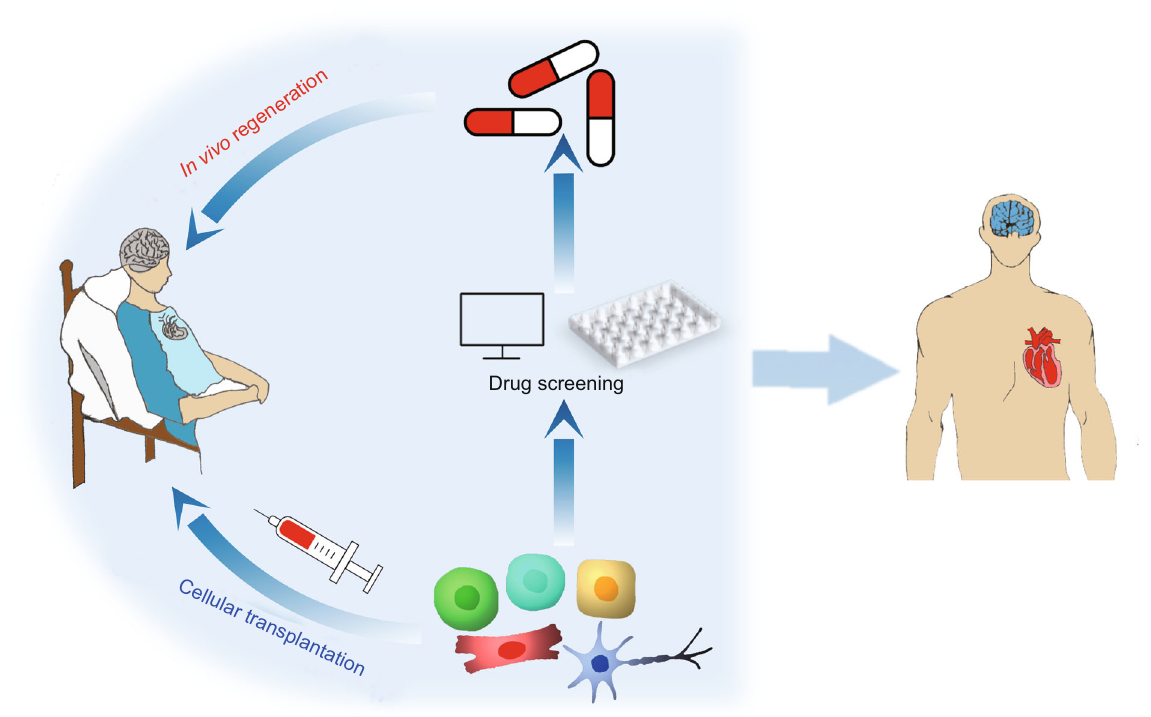
Figure 2. Potential applications of cellular reprogramming. Cellular reprogramming can provide a large number of functional cells, which can be used for cell-based transplantation and high-throughput chemical screenings. This technology will help develop drugs to stimulate patients ’ endogenous cells to repair and regenerate in vivo in the near future. Cellular reprogramming by only small molecules will signi fi cantly advance biomedical studies and clinical applications, and realize the long-term goal of curing